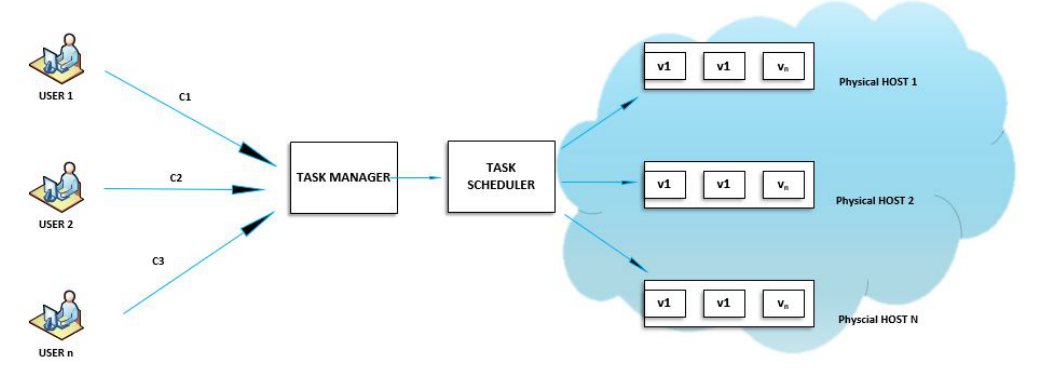
Figure 4. Task scheduling system model in cloud